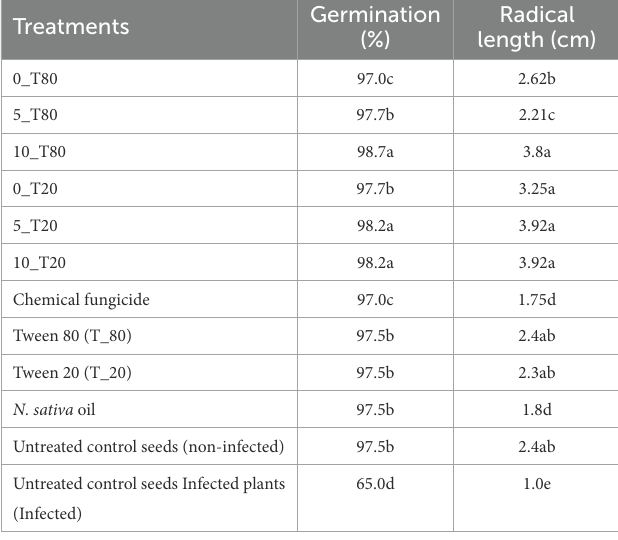
TABLE 2 Effect of the six nanoemulsions treatments on germination of maize seeds and their radical length after infection with P. verrucosum . Treatments